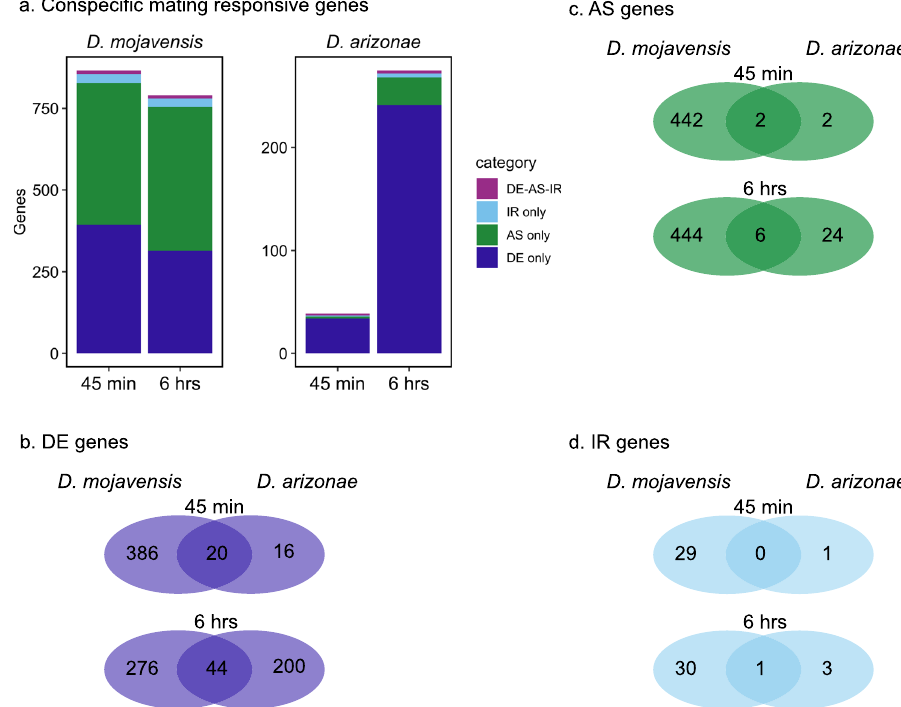
Fig. 3 Conspeci fi c postmating transcriptional response in D. mojavensis and D. arizonae . a Number of conspeci fi c mating responsive genes with signi fi cant patterns of DE, AS and IR following conspeci fi c matings in D. mojavensis and D. arizonae . All comparisons were performed against virgin females at 45 min and 6 h postmating (FDR α = 0.05). Genes in the DE-AS-IR category, showed signi fi cance in two or more of the individual categories (DE, AS and/or IR). Venn diagrams comparing signi fi cant b DE genes, c AS genes, and d IR genes from conspeci fi c matings in each species. Overlapping genes represent the conserved postmating response, while species-speci fi c genes indicate divergence in the postmating response. The distinct expression and splicing patterns indicate substantial differences in the postmating transcriptional response between the species.